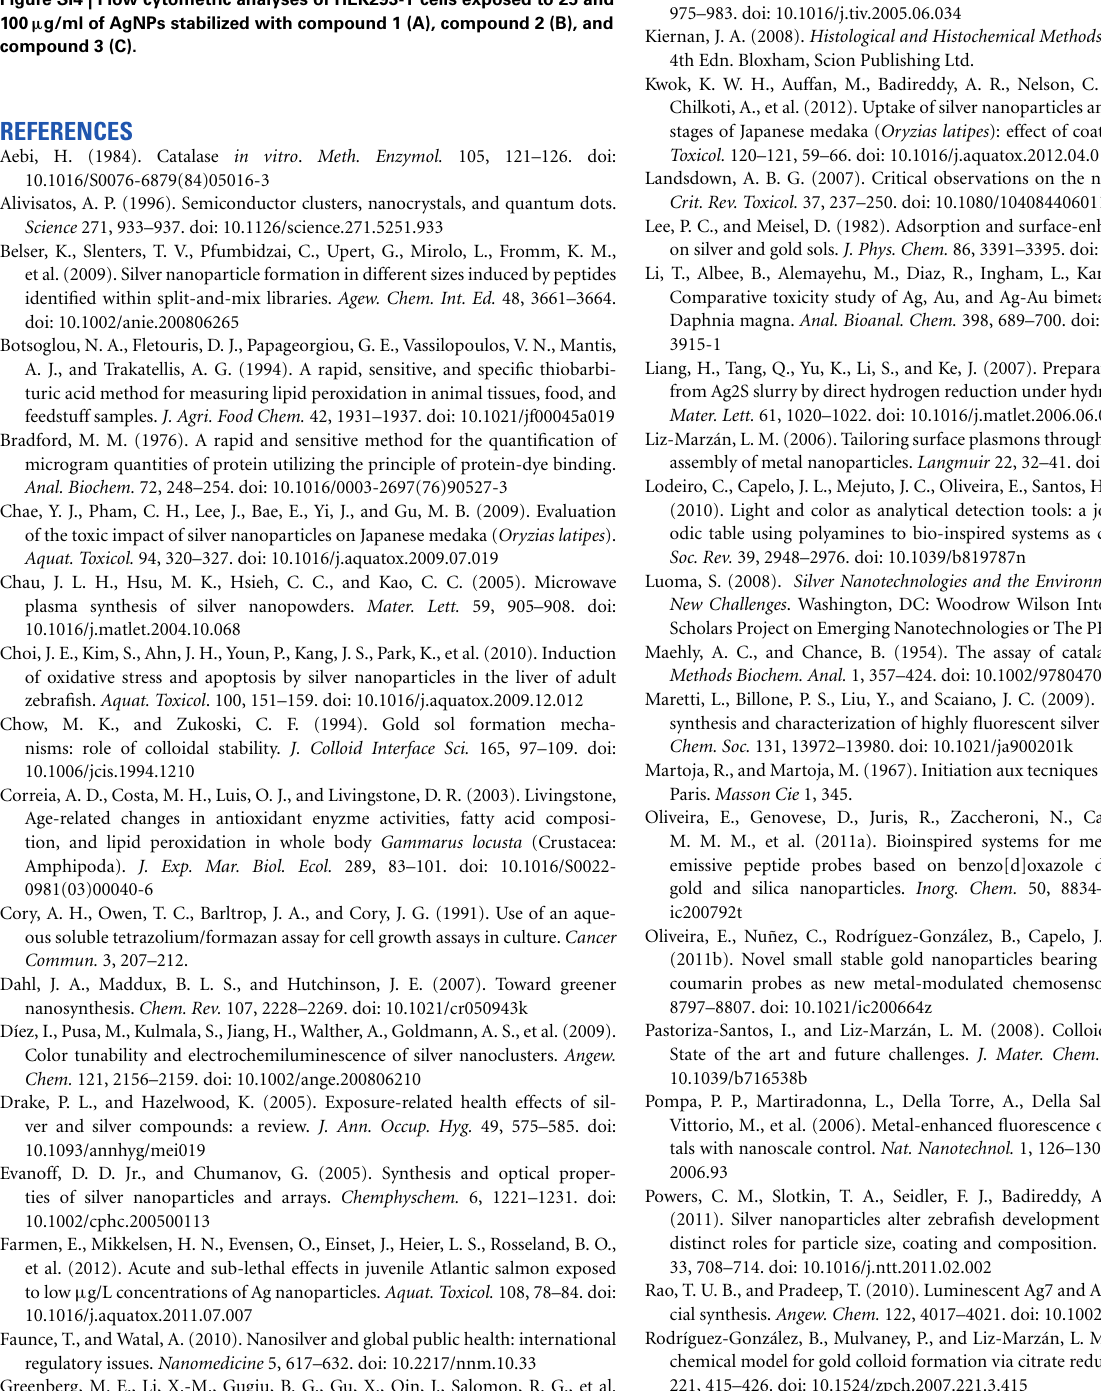
Figure SI3 | Comparative cytotoxicity against HepG2 cells after 72h of treatment with AgNPs (stabilized with compounds 1, 2, and 3) at 100 µ g/ml. Representative optical microscopy images of control cells (A) and AgNPs treated cells (B–D) are shown. Green and red arrows indicate viable and non-viable HepG2 cells, respectively. Cell viability of HepG2 cells was evaluated by XTT assay (E) . Figure SI4 | Flow cytometric analyses of HEK293-T cells exposed to 25 and 100 µ g/ml of AgNPs stabilized with compound 1 (A), compound 2 (B), and compound 3